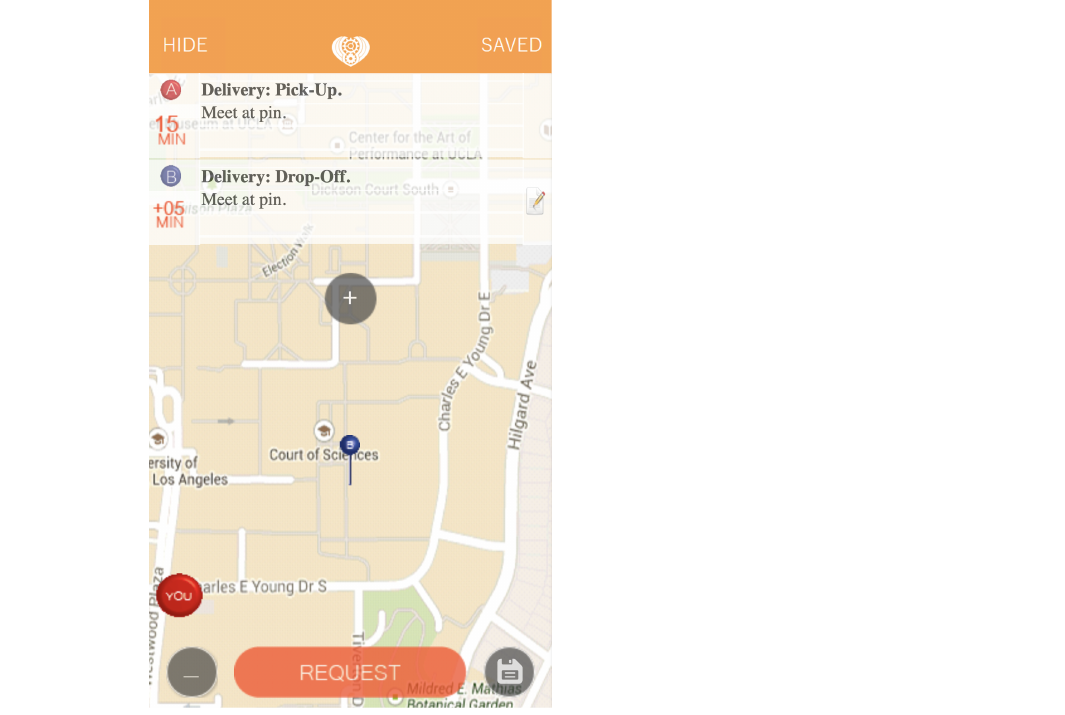
Figure 8. A screenshot of a prototype mobile app that enables the zero-emission delivery